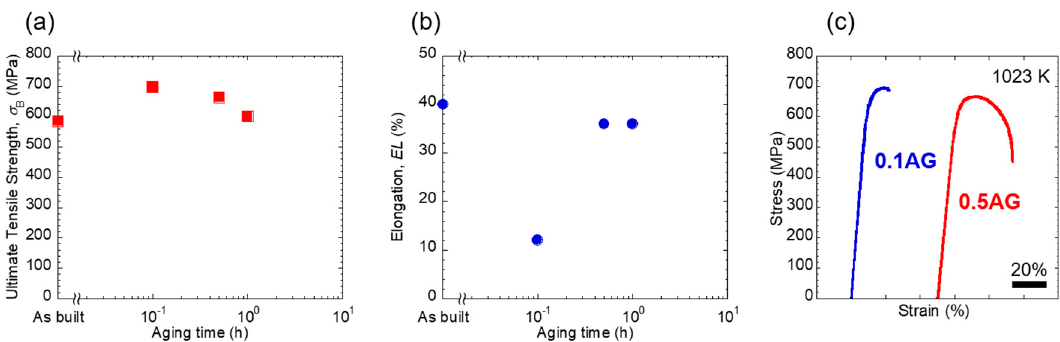
Figure 7. Variations in σ B ( a ) and EL ( b ) of the aged alloys at 1023 K with aging time and S – S curves of 0.1AG and 0.5AG tensile deformed at 1023 K ( c ).